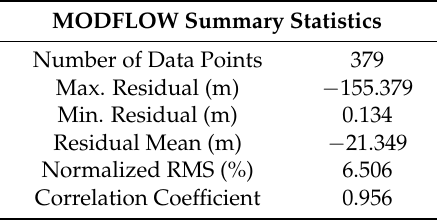
Table A6. Summary statistics for the MODFLOW